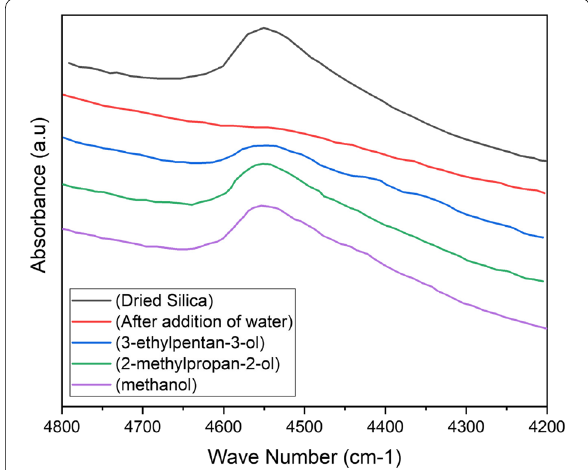
Fig. 7 Reactivity of silanol groups presents on silica surface via In situ‑ IR spectroscopy with different ROH